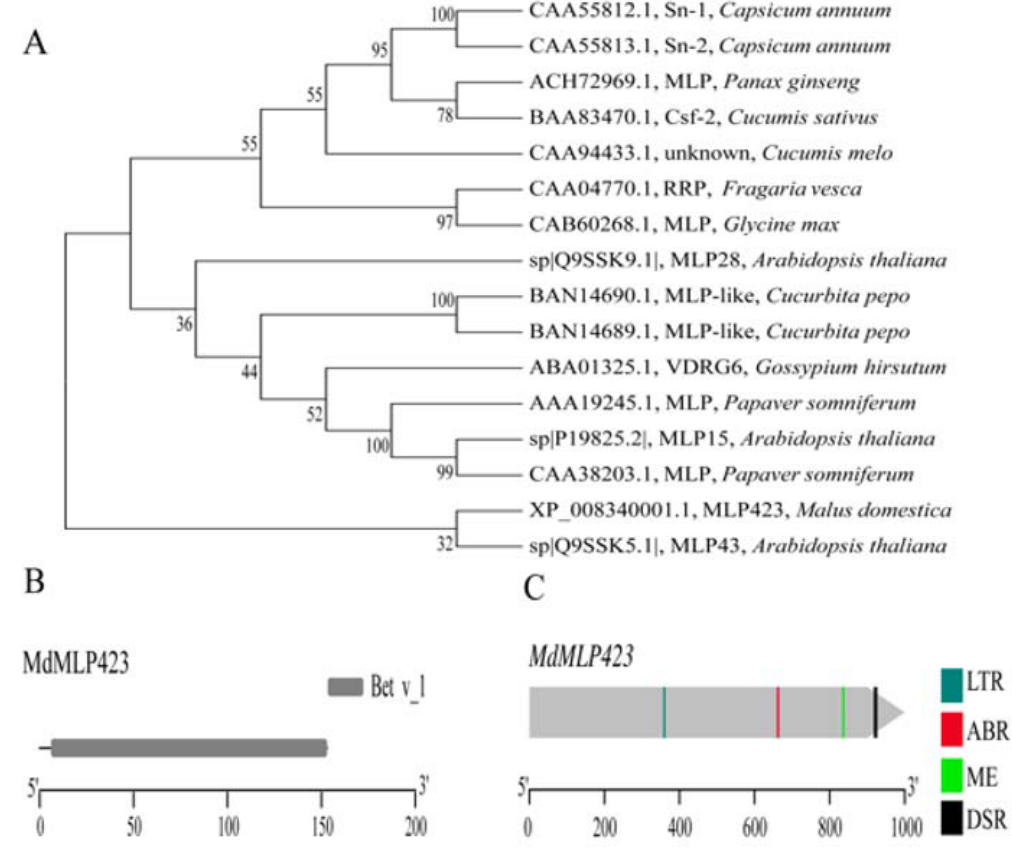
Figure 1. Phylogenetic analysis, protein structure and cis ‐ acting elements of MdMLP423. ( A ) Phylogenetic analysis, protein structure and cis -acting elements of Phylogenetic analysis of the MdMLP423 protein with its orthologous genes in other plant species. ( B ) Conserved domain analysis of the MdMLP423 protein. ( C ) Various cis ‐ acting elements of the MdMLP423 promoter.